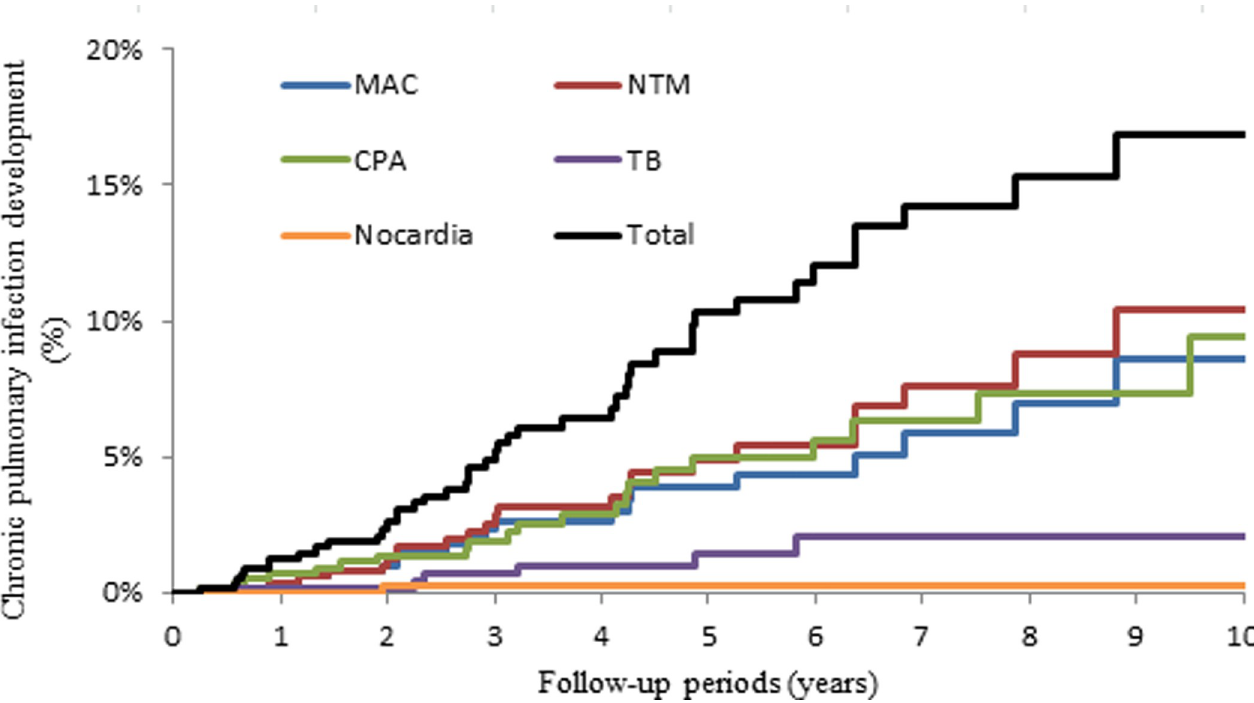
Fig 2. Kaplan-Meier curves for the time until the development of CPI (Groups A and B). CPA = chronic pulmonary aspergillosis; MAC = Mycobacterium avium complex pulmonary disease; NTM = nontuberculous mycobacteriosis; TB = tuberculosis.